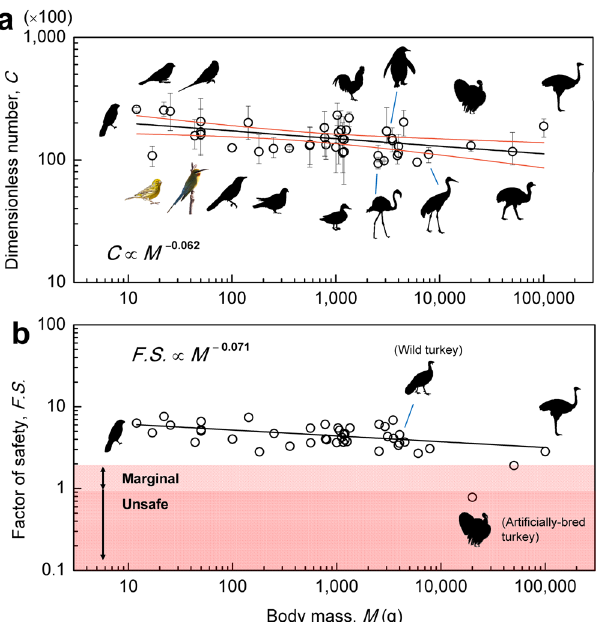
Figure 2. The C number and factor of safety based on freshly laid eggs (Method 1). ( a ) The experimental C versus body mass with one point per species. Symbols represent experimental measurements (error bars are the intraspecific maximum and minimum values), black line represents the best fit to the data, and red lines represent the 95% confidence intervals. ( b ) Factor of safety F.S . = C / C cr . Solid lines represent best fits to the data. Error bars are the intraspecific maximum and minimum values. See Supplementary Dataset 2 for details on the source of bird